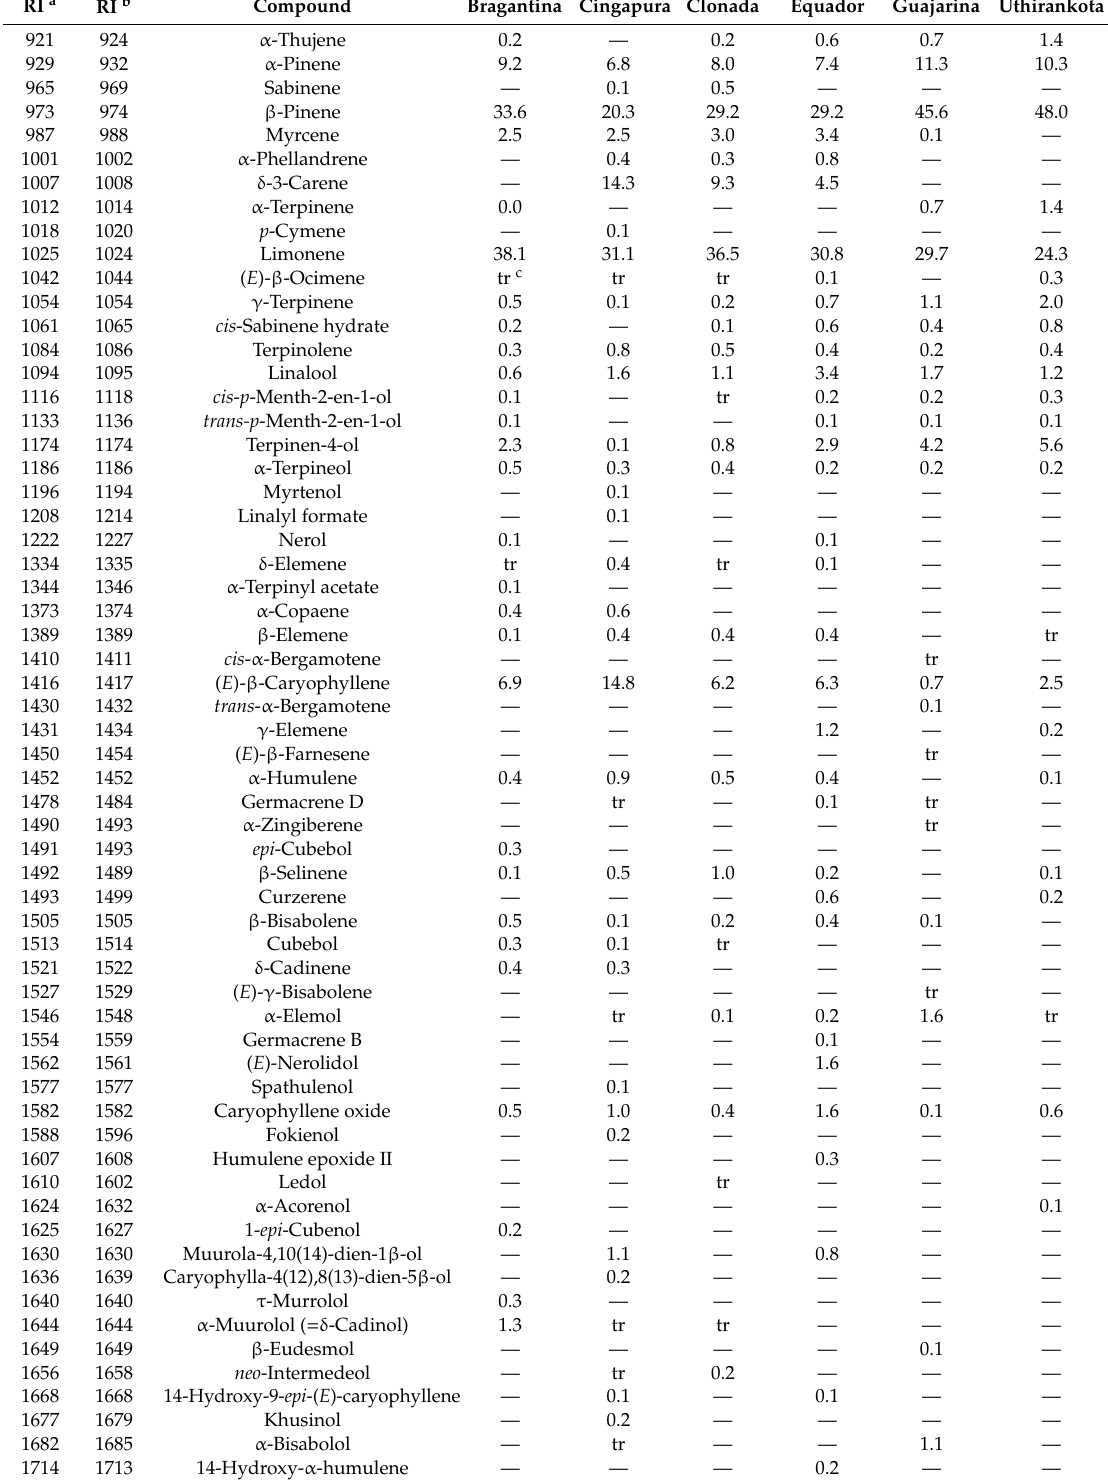
Table 2. Chemical compositions of Piper nigrum fruit volatile oils cultivated in Par á State, Brazil. RI a RI